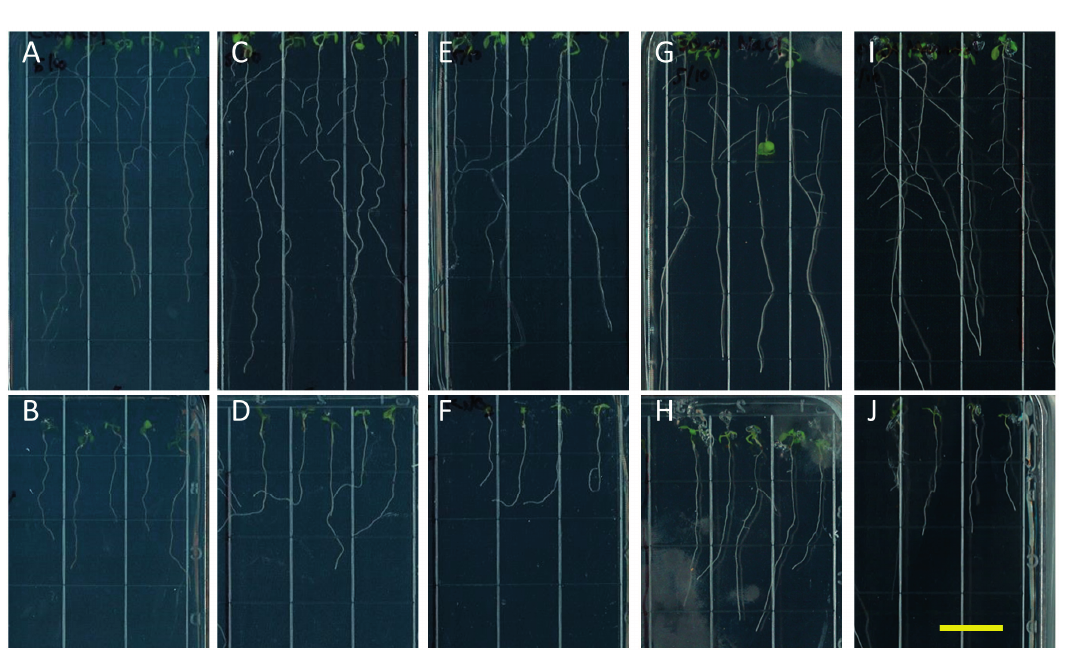
Figure A3. nhx1nhx2nhx3nhx4 root tip curling is K + specific. Six-days-old WT ( A , C , E , G ) and nhx1nhx2nhx3nhx4 ( B , D , F , H ). Both WT and nhx1nhx2nhx3nhx4 exhibit straight root growth on media containing 1 mM KCl ( A , B ). When grown on media supplemented with either 30 mM KCl ( C , D ) or 30 mM KNO 3 ( E , F ), WT roots grow normally, whereas roots of nhx1nhx2nhx3nhx4 exhibit a left-handed curling. Neither 30 mM NaCl ( G , H ) nor 60 mM mannitol ( I , J ) induced root curling, although the addition of NaCl produced longer root growth in nhx1nhx2nhx3nhx4 ( H ) compared with other treatments. The yellow bar is 1 cm.